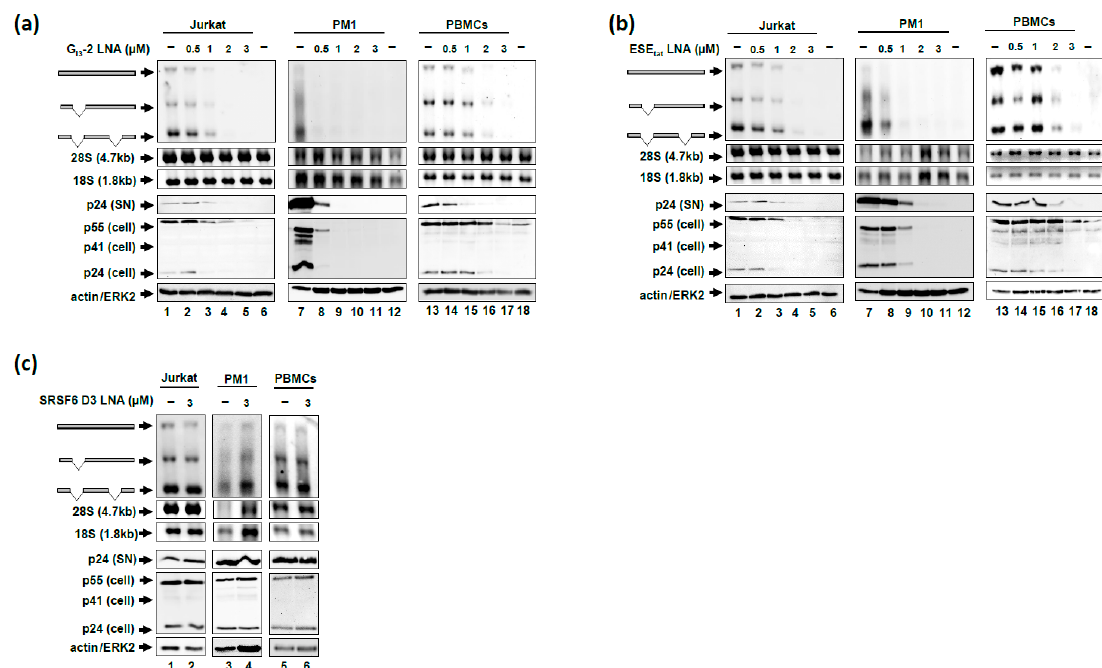
Figure 4. Interference of “nakedly” delivered G I3 -2 and ESE tat LNA mixmers with HIV-1 replication. Six hours after infection (NL4-3, MOI: 0.005) of Jurkat cells, PM1 cells or PBMCs with the laboratory strain NL4-3 the G I3 -2 ( a ) and ESE tat ( b ) LNA mixmers were added to the cell culture medium (0.5, 1, 2 and 3 µM). The “naked” delivery of the SRSF6 D3 LNA ( c , 3 µM) served as the control. Total RNA and protein as well as virions from the supernatant were harvested six days post-delivery. The three viral mRNA classes were detected performing northern blot analysis using a DIG-labeled HIV-1 exon 7 probe. Cellular and supernatant p24 CA protein levels were determined by immunoblot analysis using an anti-p24 CA antibody. Detection of actin (Jurkat cells and PBMCs) or ERK2 (PM1 cells) served as loading control. In a and b lanes 6, 12 and 18 represent mock samples.